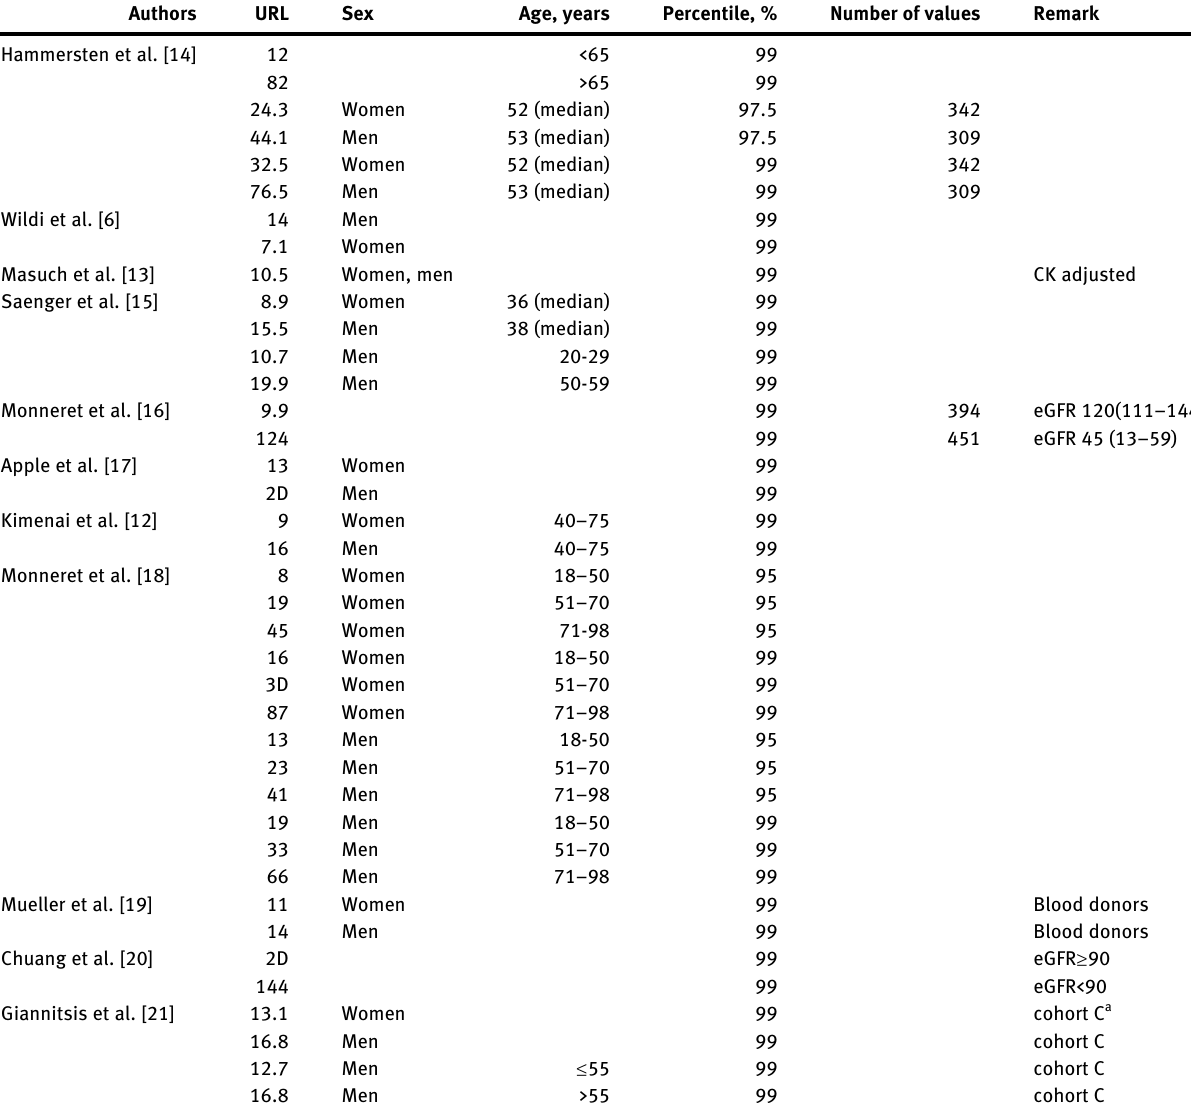
Table  : Upper reference limits of hs-cardiac troponin T(ng/L) reported by several authors (estimated by direct methods).